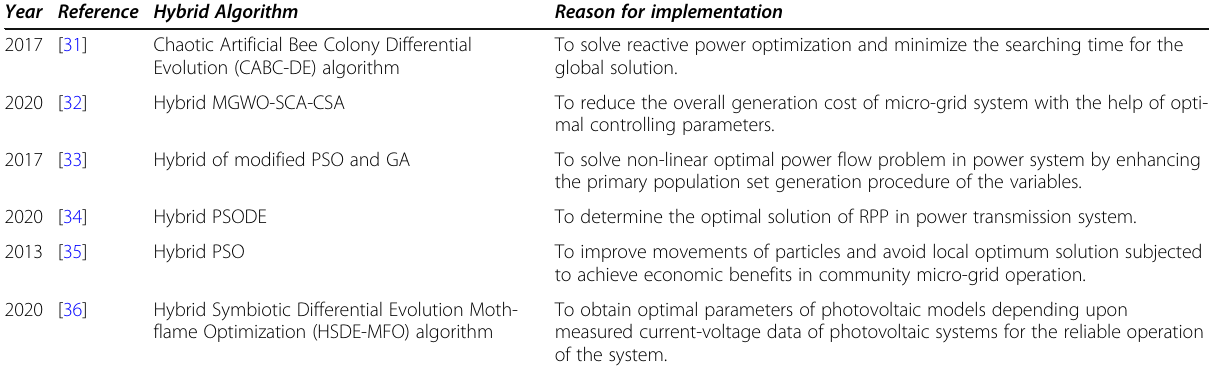
Table 2 Different hybridization methods Year Reference Hybrid